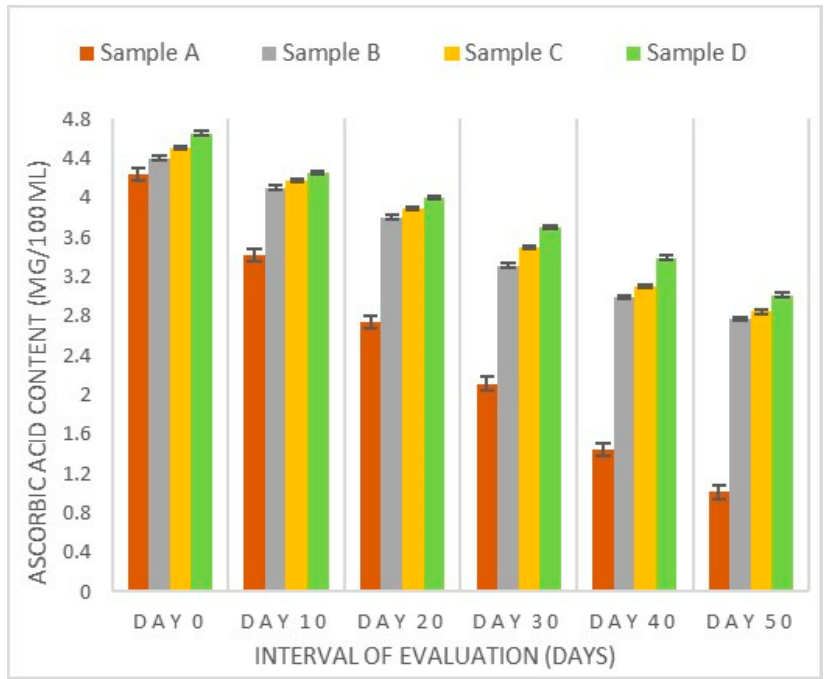
Figure 5. Ascorbic acid evaluation of samples.